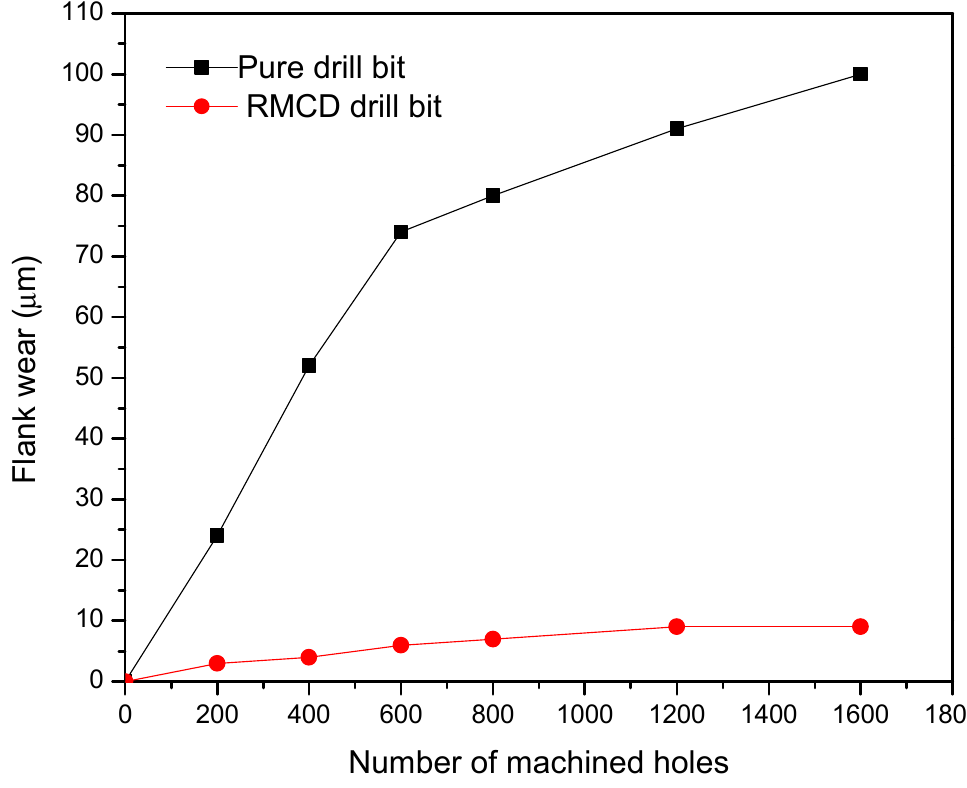
Figure 4. Flank wear width as a function of the number of machined holes by the pure and RMCD drill bits.